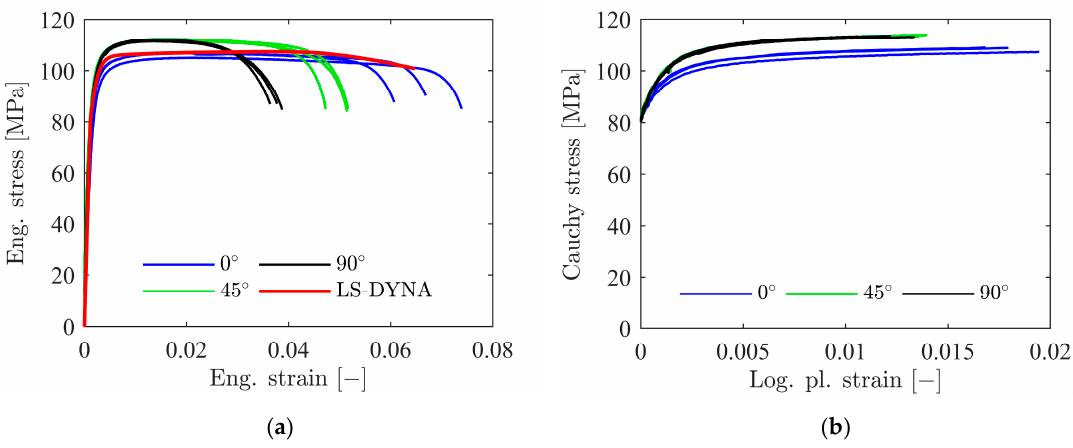
Figure 1. ( a ) Engineering stress-strain curves based on two-dimensional digital image correlation (2D-DIC) measurements and ( b ) Cauchy stress-logarithmic plastic strain curves until necking in different material orientations regarding the rolling direction for aluminium alloy 1050A-H14.